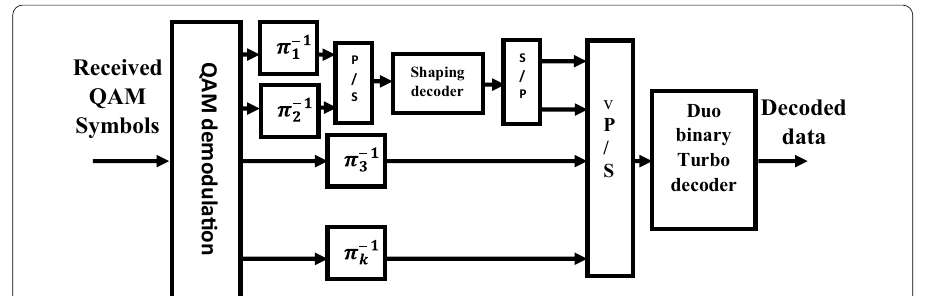
Fig. 4 Received block of the BICM constellation shaping scheme. BICM_CS ( − 1 ) Scheme. The received part of the proposed SISO BICM constellation shaping scheme (the i th BICM_CS ( − 1 ) block in the reception part of the global adaptive scheme)